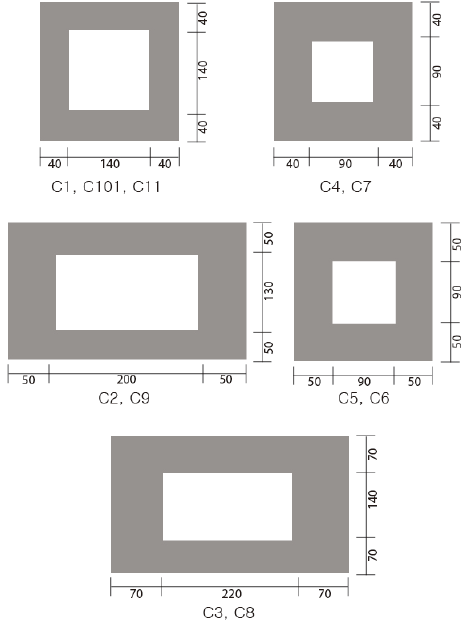
Figure 3. Typical nonlinear fluid viscous damper [24].